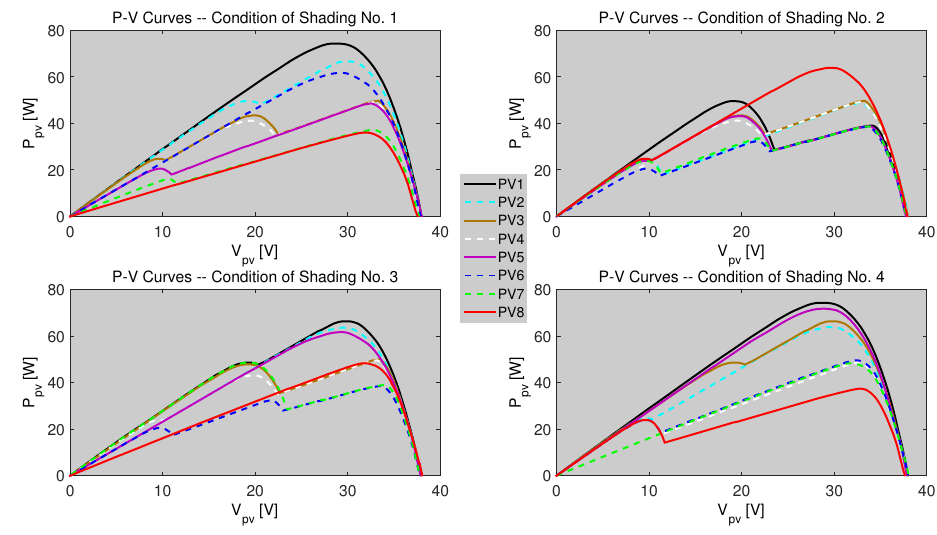
Figure 10. P-V curves of the PV panels for the shading conditions.